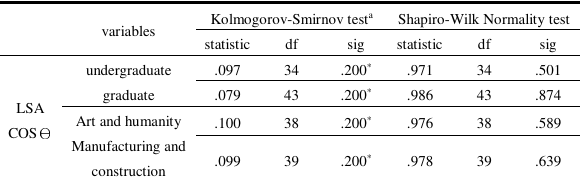
Table 5 LSA COS θ Normality test